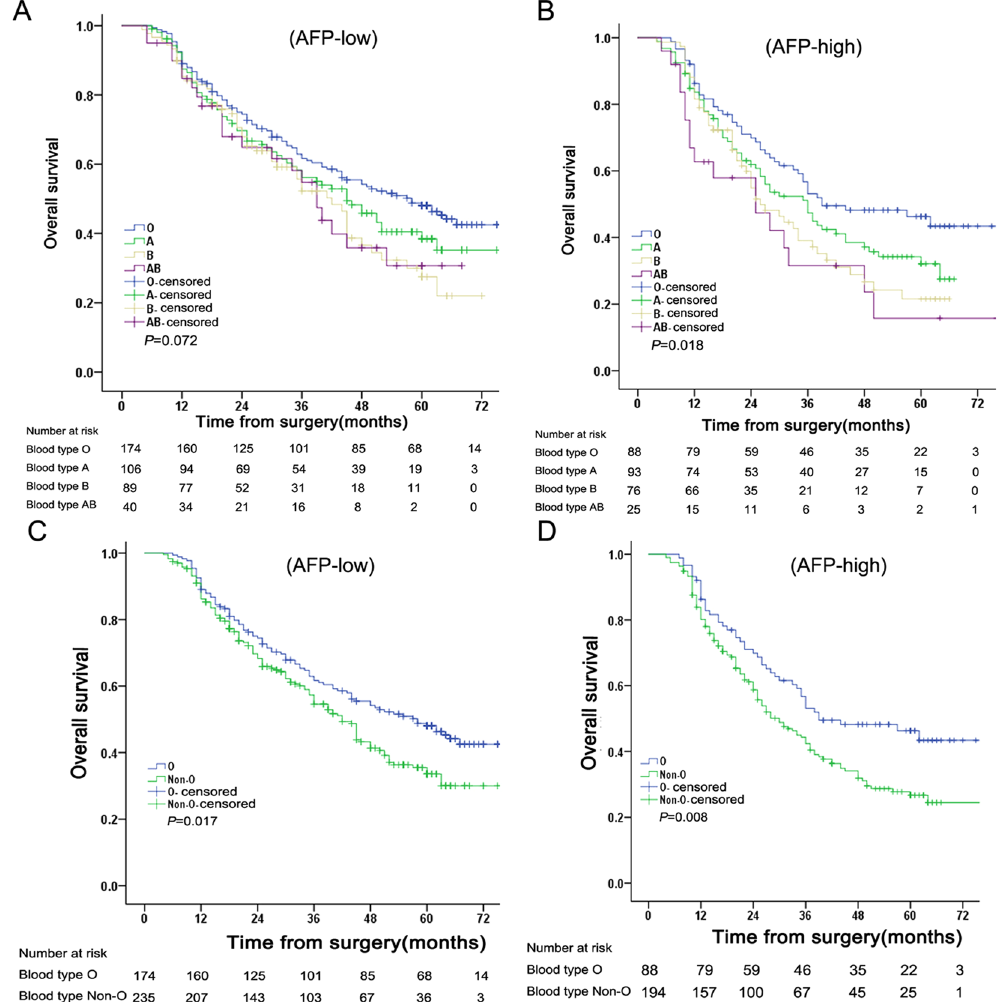
Figure 2. Overall survival (OS) of HCC patients according to α -fetoprotein (AFP). ( A ) OS of patients with low AFP levels according to ABO blood type. ( B ) OS of patients with high AFP levels according to ABO blood type; ( C ) OS of patients with low AFP levels according to blood type O and non-O blood types. ( D ) OS of patients with high AFP levels according to blood type O and non-O blood